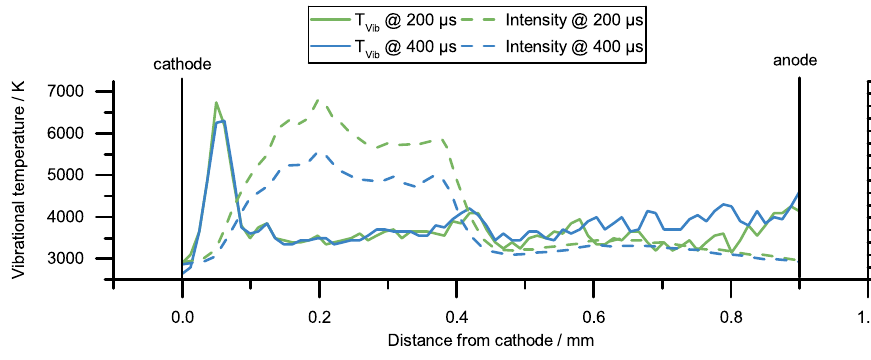
Fig. 9 Vibrational tempera- ture (solid lines) and intensity (dashed lines) at 200 µs (green) and 400 µs (blue) after break- down depending the distance to the cathode